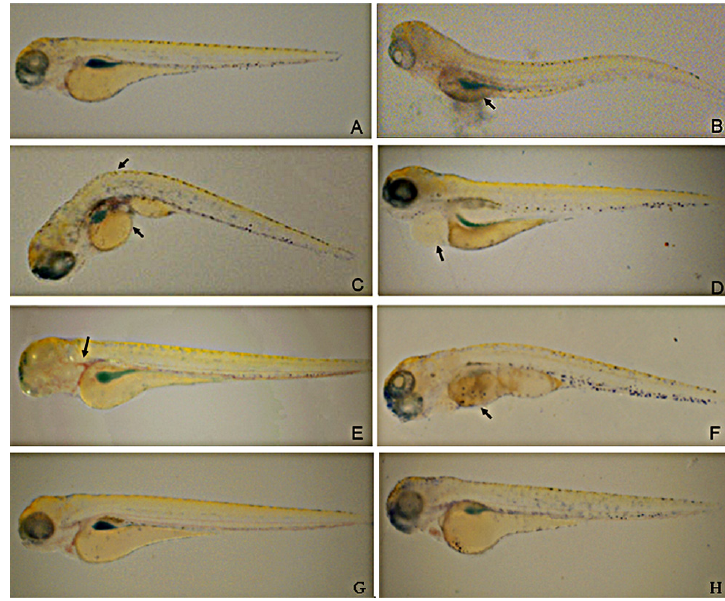
Figure 1. The induction of LPS on inflammation phenotype in zebrafish. The yolks of zebrafish larvaes were injected with 0.5 mg/mL LPS to induce reproducible morphological abnormalities at 24 h. Figure B – F present the observed morphological